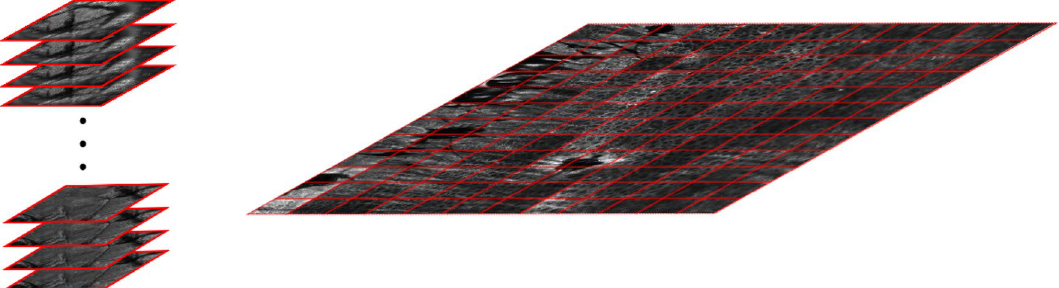
Figure 1. RCM Imaging modalities. (left) A 3D stack of RCM images (0.5-by-0.5 mm) used to determine the depth of different skin strata. (right) A mosaic of RCM images (6mm-by-6mm). Red borders in the mosaic represent single RCM images of the same dimensions as in the